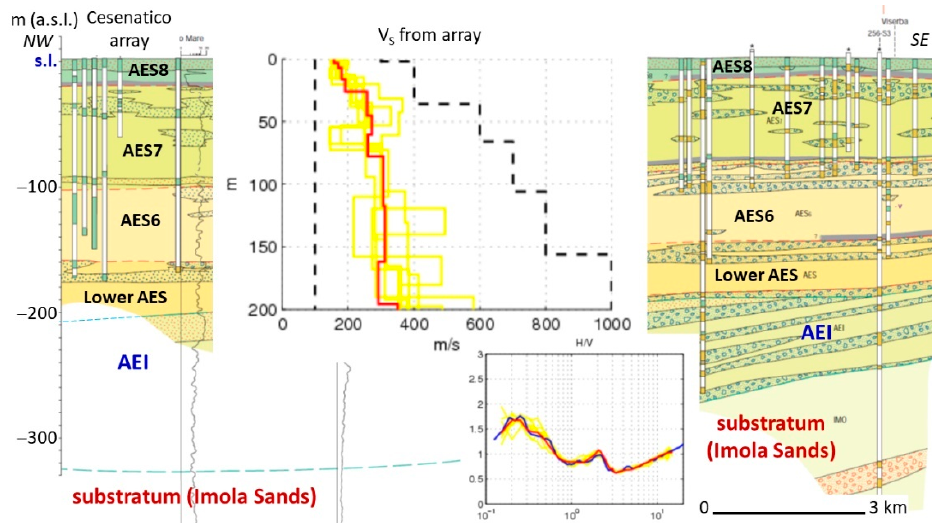
Figure 20. Geological cross-section along the coast from Cesenatico to Viserba (from Geological Map of Italy, sheet no. 256 “Rimini”), H/V spectral ratio and Vs profile from ambient vibration measurement (array) in the Cesenatico urban area [38].